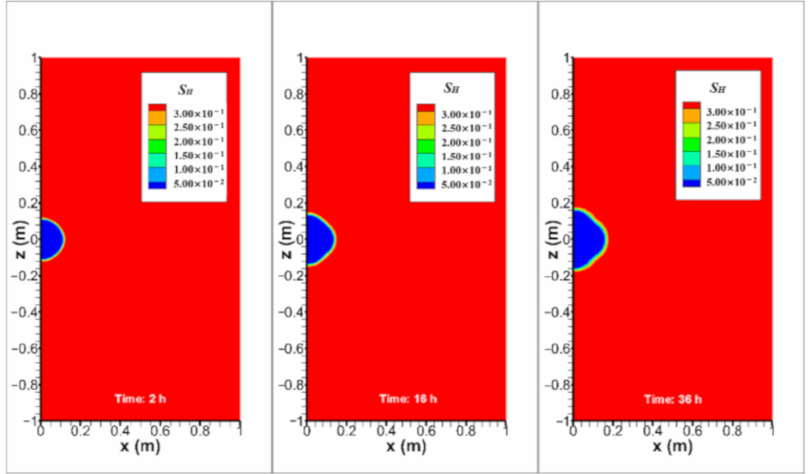
Figure 4. NGH saturation distribution evolution around the wellbore.